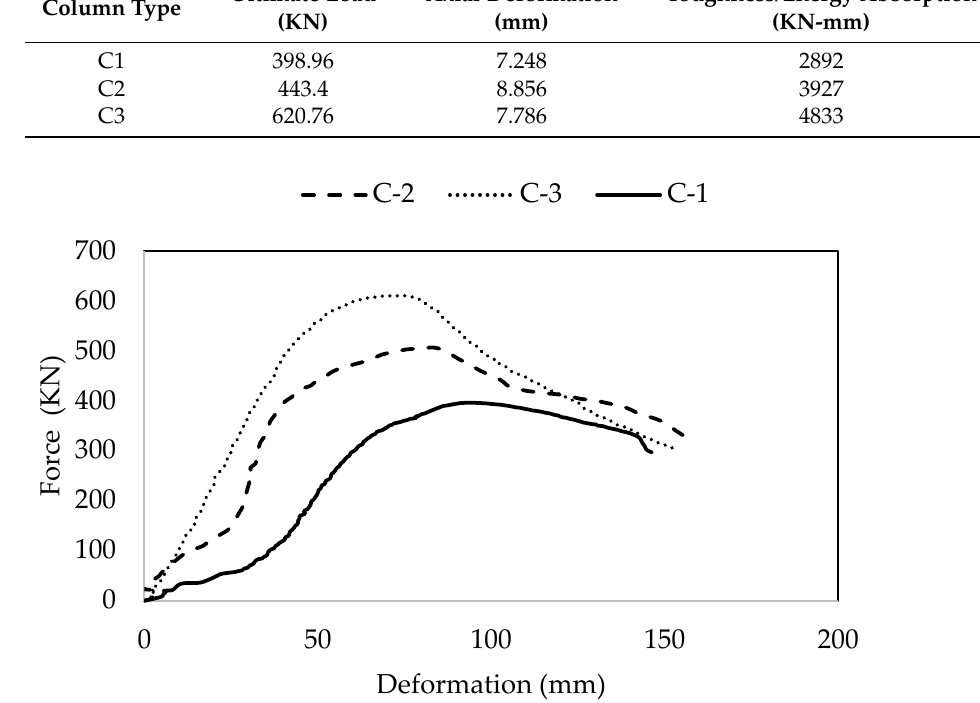
Figure 10. Force-deformation curves of confined concrete specimen.